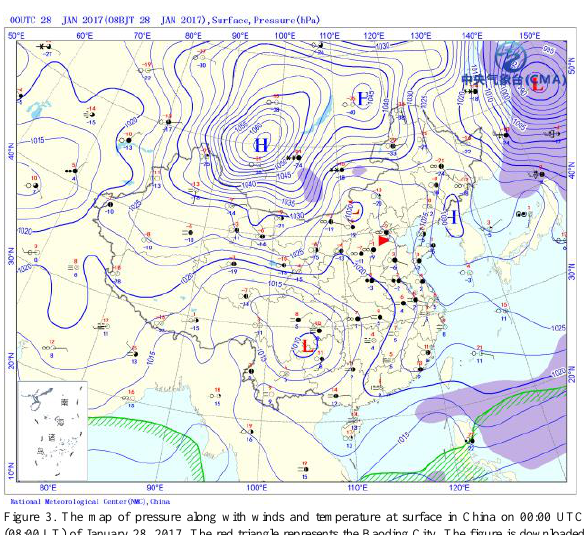
Figure 3. The map of pressure along with winds and temperature at surface in China on 00:00 UTC (08:00 LT) of January 28, 2017. The red triangle represents the Baoding City. The figure is downloaded from National Meteorological Center,